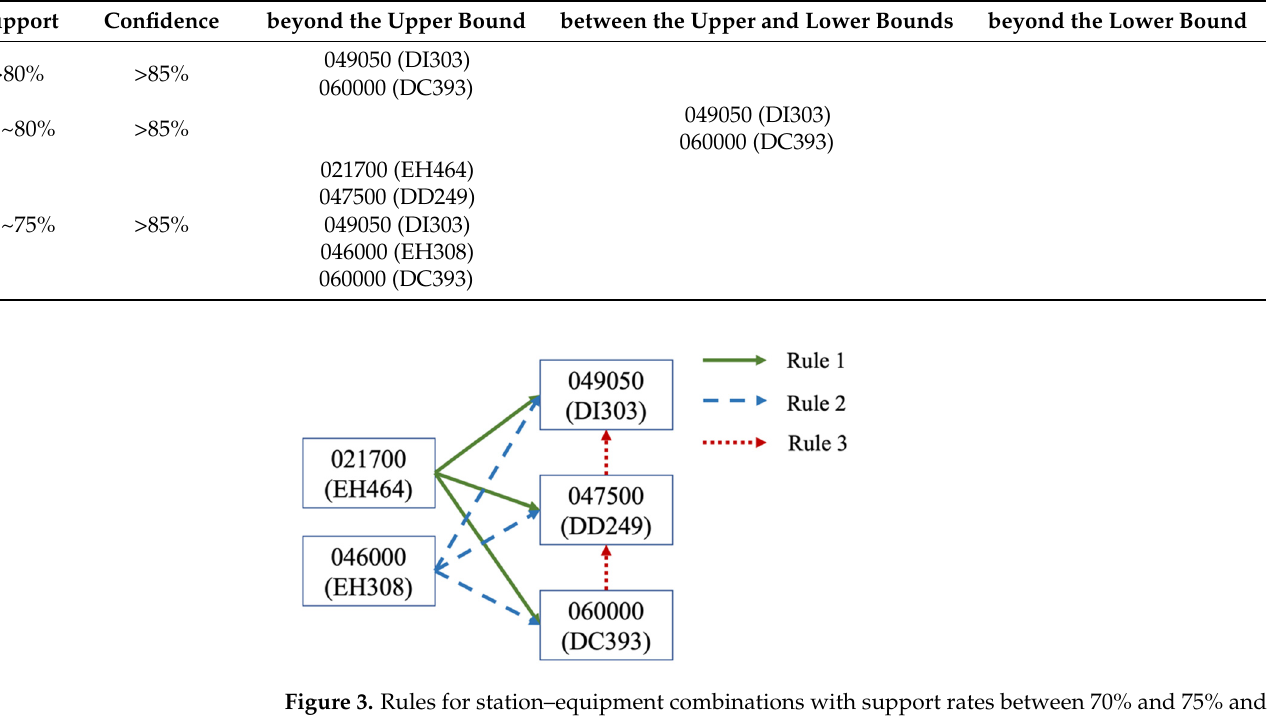
Table 2. Results of association rules using individual control-boundary clustering.